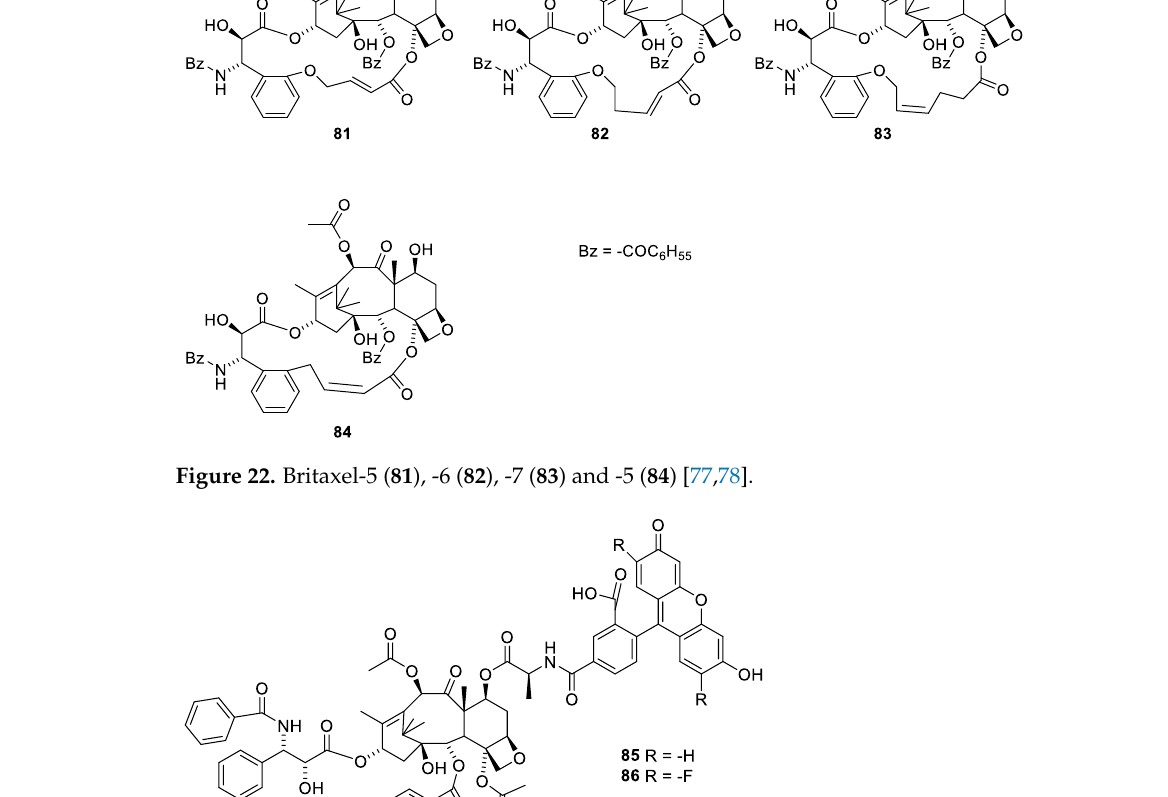
Figure 23. Flutax 1 ( 85 ), Flutax 2 ( 86 ) [81].